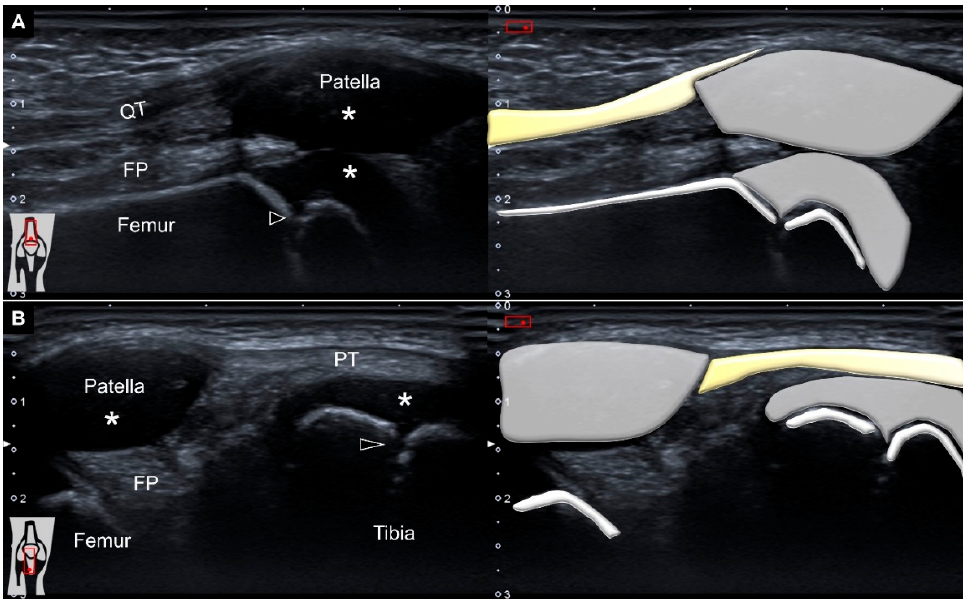
Figure 1. Ultrasound imaging and schematic drawing of the ( A ) suprapatellar and ( B ) infrapatellar regions. QT: quadriceps tendon; FP: fat pad; PT: patellar tendon; *: hyaline cartilage; black arrowheads: growth plate.